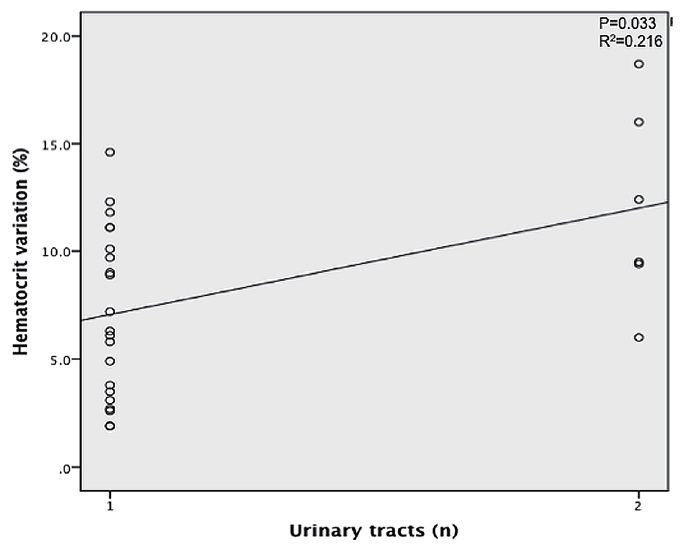
Figure 1 - Correlation between number of urinary tracts and drop in hematocrit